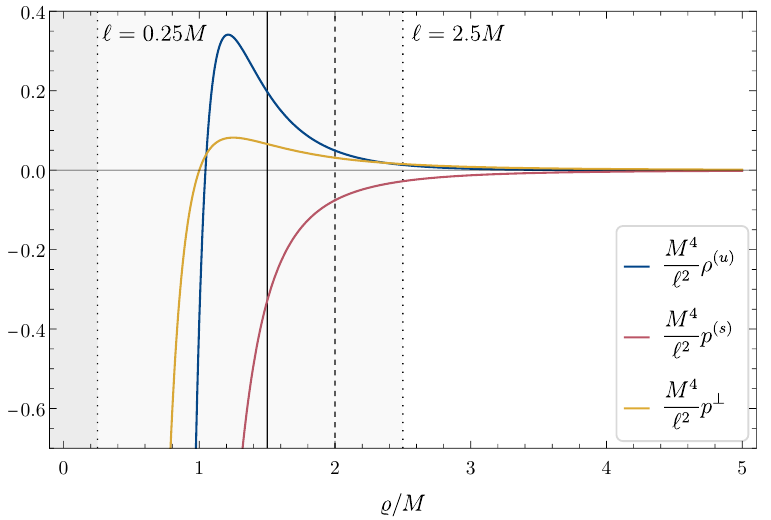
Figure 5. Energy density and principal pressures, as measured by an observer comoving with the æther, for the black-bounce non-singular metric in the minimal theory α = β = 0 . The black vertical lines mark the UH (solid) and KH (dashed), which may be present or not depending on the value of ‘ . Dotted lines signal the position of the mouth for two choices of ‘ , corresponding to a hidden ( ‘ = 0 . 25 M ) and a traversable ( ‘ = 2 . 5 M ) wormhole respectively. Recall that, since √ % = r 2 + ‘ 2 , the region % < ‘ is unphysical and should be removed; for this reason it is shaded. For symmetry reasons, the throat is an extremal point (either a local minimum or maxi- mum) for these